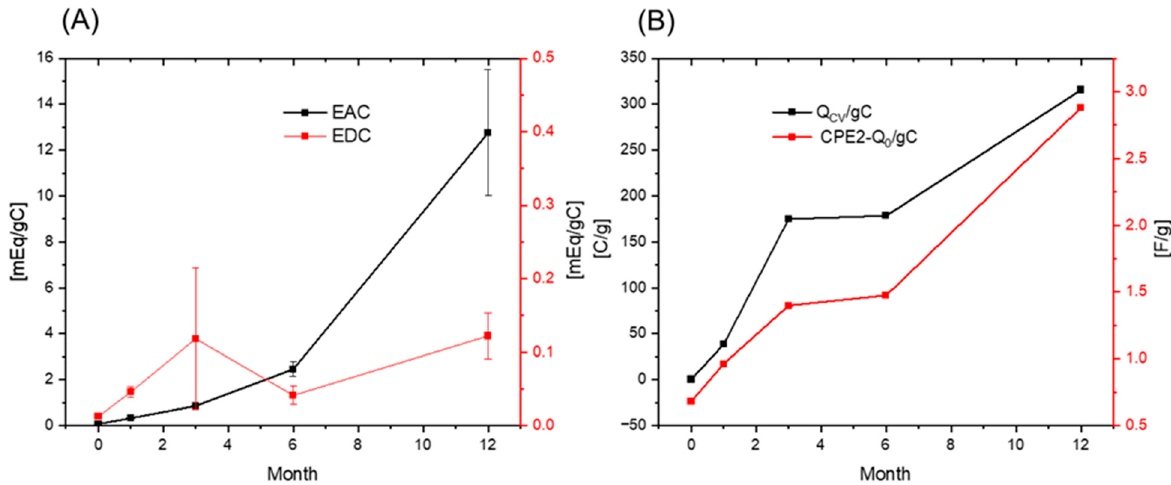
Figure 7. ( A ) Electron accepting capacity (EAC) and electron donating capacity (EDC) of rice straw ‐ artificial soil mixtures with 0, 1, 3, 6 months, and one year of humification (Mix ‐ 0M ‐ C, Mix ‐ 1M ‐ C, Mix ‐ 3M ‐ 1, Mix ‐ 6M ‐ C, and Mix ‐ 1Y ‐ C). ( B ) Changes in the specific electric capacitance per carbon based on CV measurement, Q CV /gC (Calculation method is shown in Supplementary Information Calculation S3) and the electric capacitance per carbon estimated by EIS, CPE2 ‐ Q 0 /gC, in the Mix samples during